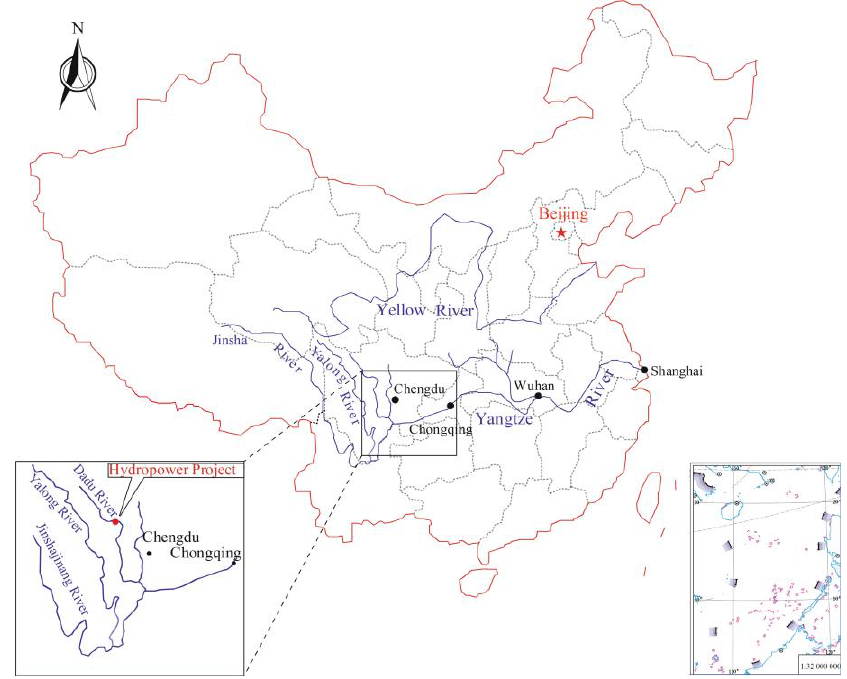
Figure 1. T he location of the hydropower station. Figure 1. The location of the hydropower station.